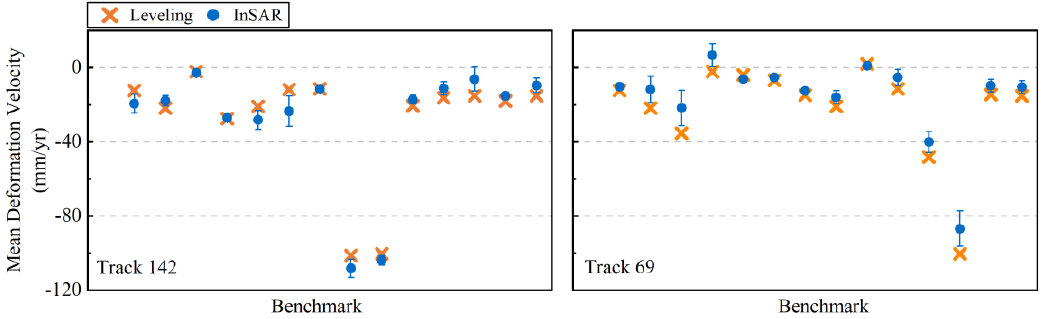
Figure 7. Comparison between the InSAR measurements and levelling data. The left panel shows the comparison between the Track 142 results and leveling measurements. And the right panel shows the comparison between Track 69 results and leveling measurements.